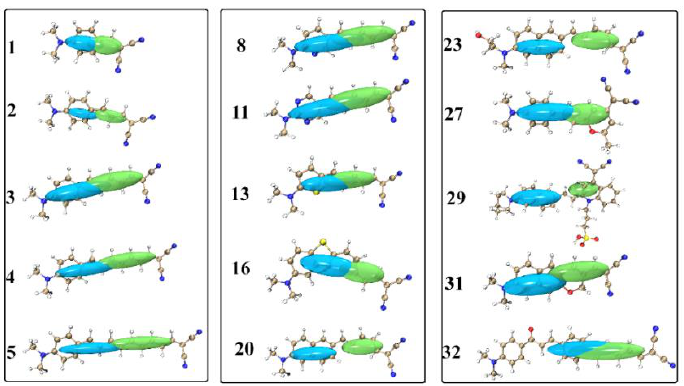
Figure 6. The hole (in blue) and electron (in green) distributions of selected probes caused by light absorption.